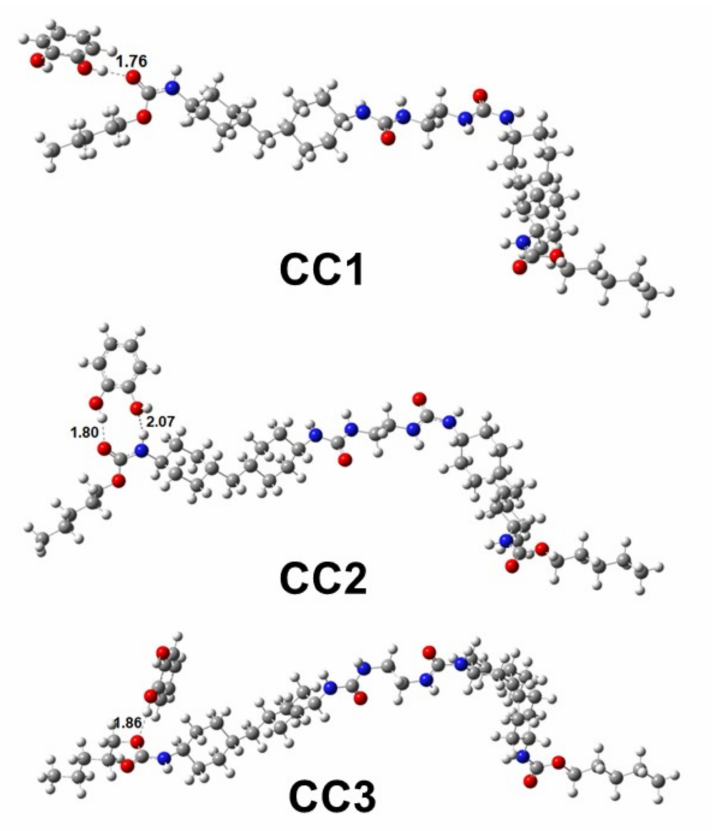
Figure 3. Three different approaches through which catechol binds with the urethane group of WBPU. Catechol forms hydrogen bonds to bind with WBPU. In CC1, CC2 and CC3 approaches, CC interacts with oxygen atom of carbonyl group, oxygen atom of carbonyl and nitrogen of amine, and oxygen atom of ether group of urethanes in WBPU,